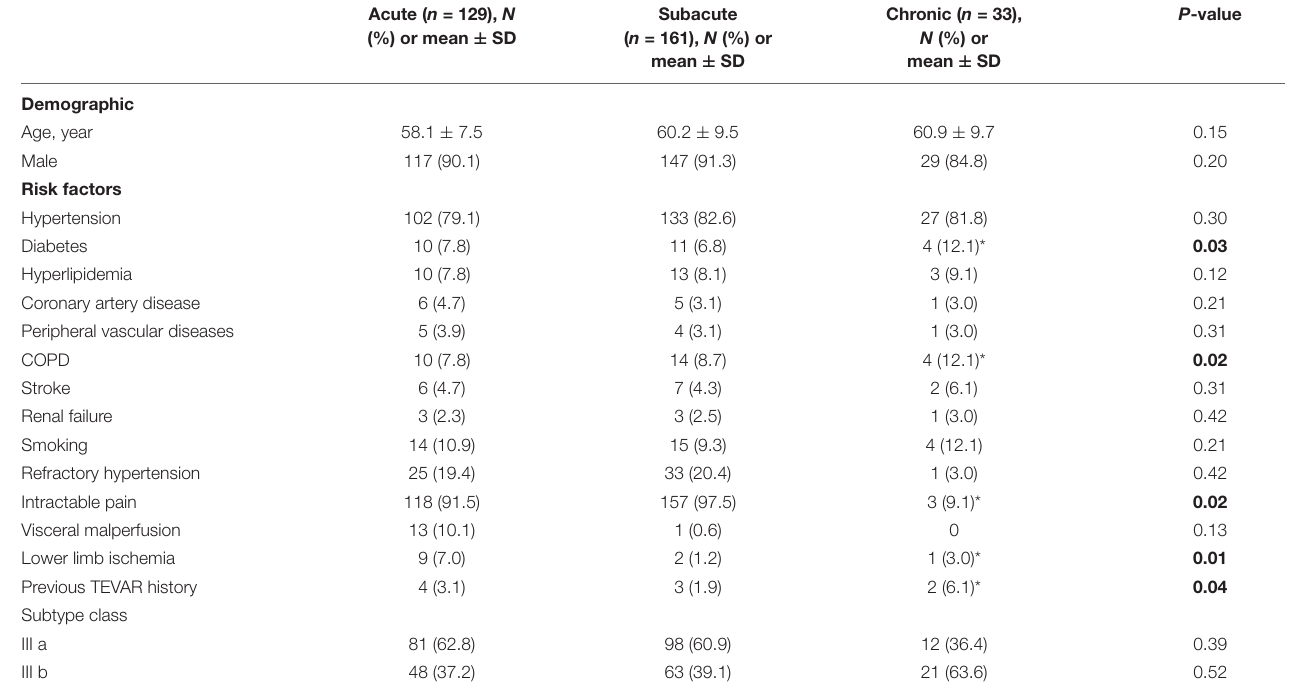
TABLE 1 | Baseline clinical data of acute, subacute, and chronic TBAD patients.